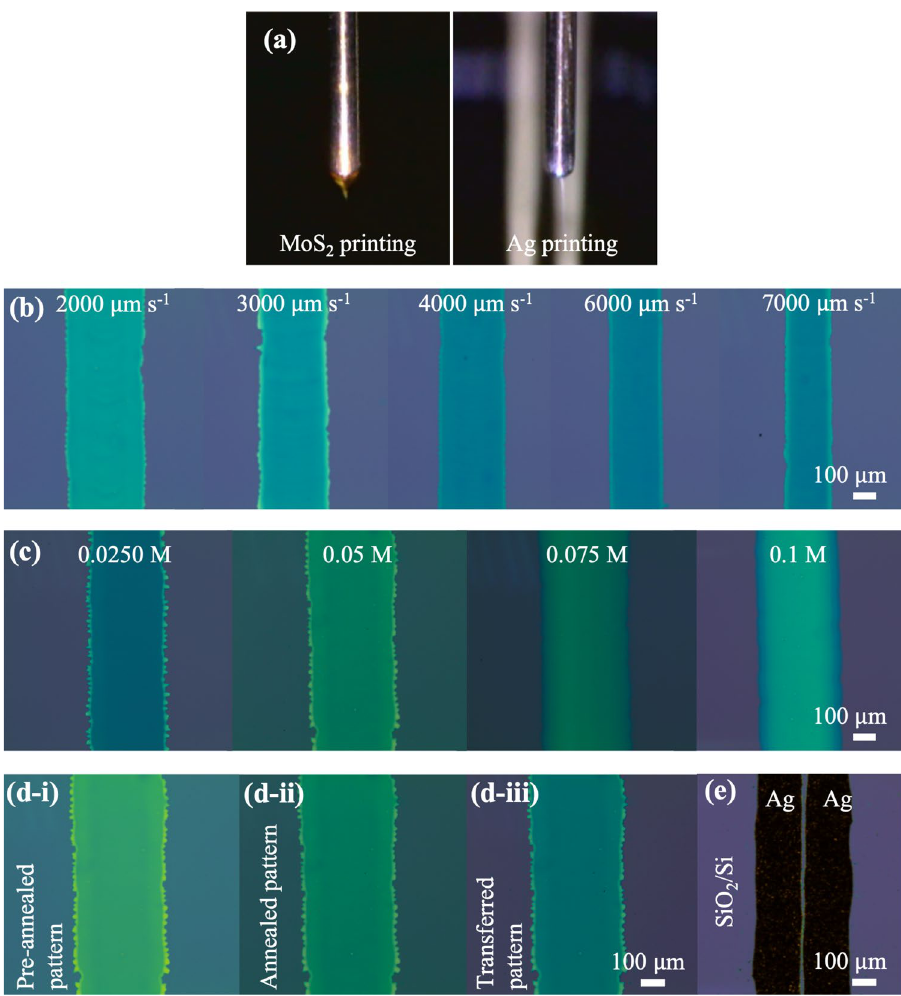
Figure 2. Taylor cone-jet mode used to print ( a ) MoS 2 and Ag lines. ( b ) Optical images of MoS 2 lines printed at various stage speeds from 2000 to 7000 µm s −1 . ( c ) Optical images of MoS 2 printed from different concentrations from 0.025 M to 0.1 M at the same stage speed of 3000 µm s −1 . ( d ) Optical images of 0.05 M concentration- based MoS 2 patterns: (i) pre-annealed and (ii) annealed on SiO 2 /Si, (iii) transferred on another SiO 2 /Si. ( e ) Optical microscope image of Ag pattern lines on SiO 2 /Si for